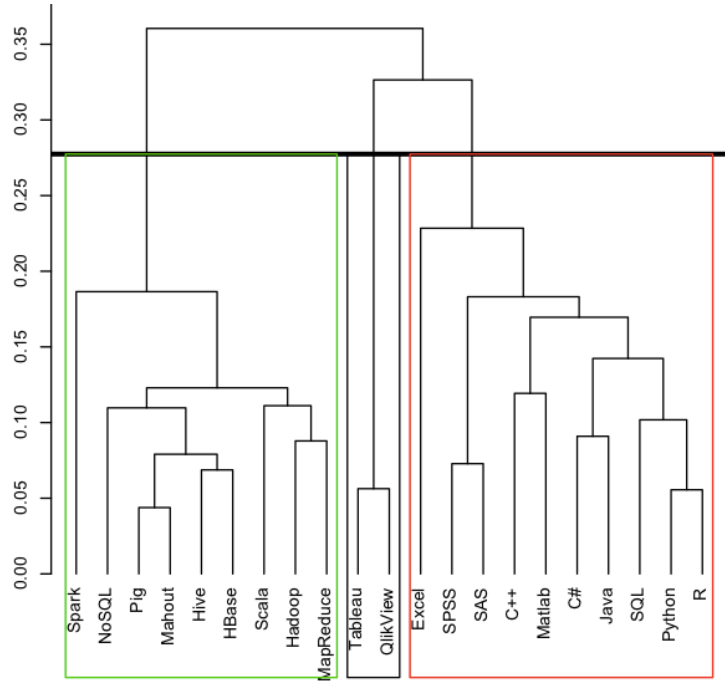
Figure 2. Hierarchical clustering, and derived 3-class partition, of the 21 software languages or environments at issue here, based on the full dimensionality, Euclidean-metric endowed, factor space. See Section 3. The agglomerative criterion is the Ward minimum variance